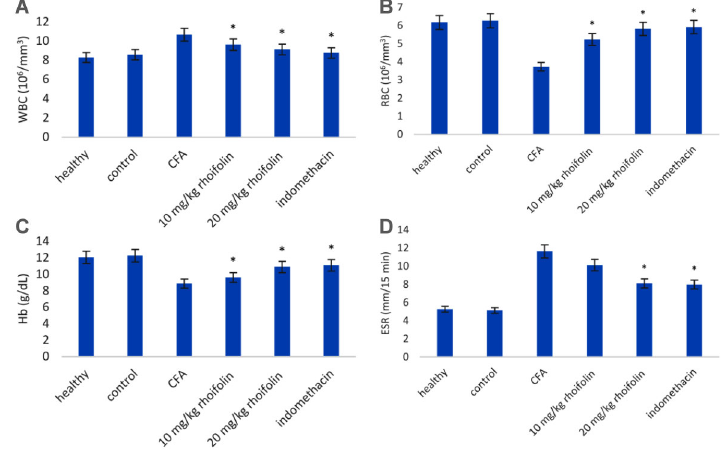
Figure 2. Effect of rhoifolin treatment on hematological parameters in complete Freund ’ s adjuvant (CFA)-induced arthritis in rats. Data are reported as means ± SE. *P p 0.05 compared to CFA-induced group (ANOVA).